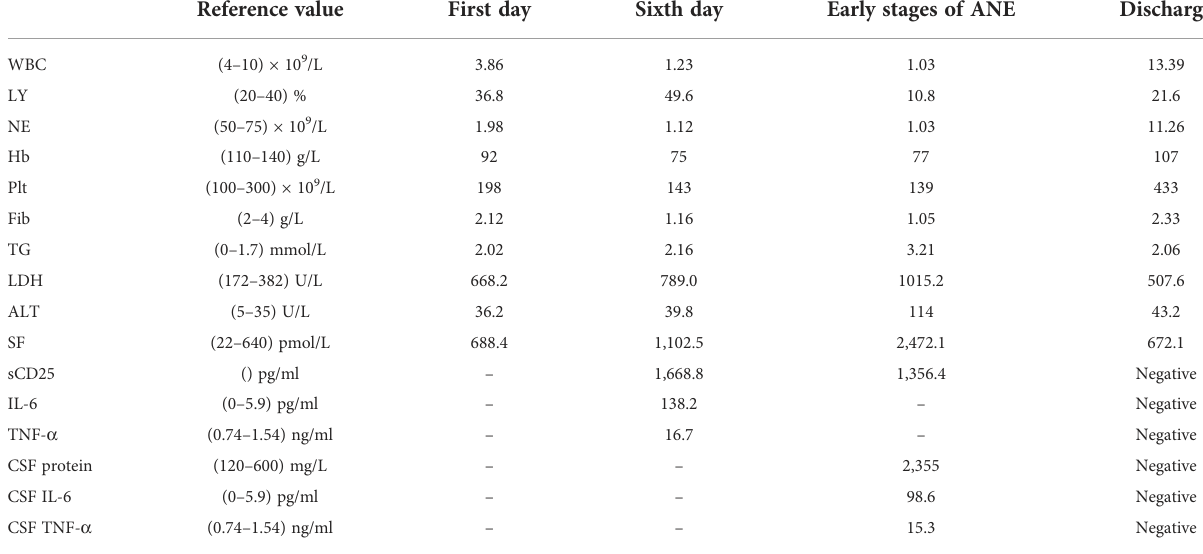
TABLE 1 Routine blood and CSF investigations of the